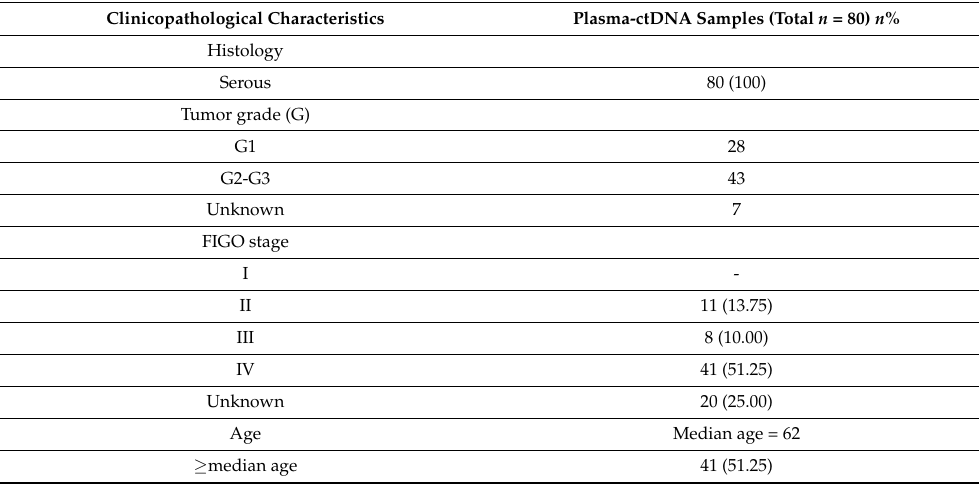
Table 2. Clinicopathological characteristics of the advanced and metastatic ovarian cancer